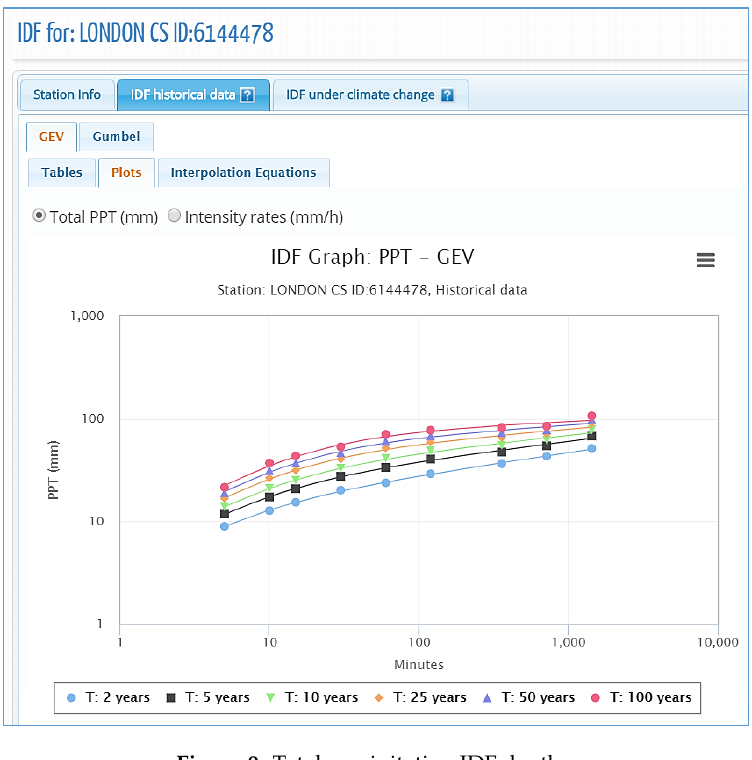
Figure 8. IDF curves for a gauged station—London CS 6144478—total precipitation depths.